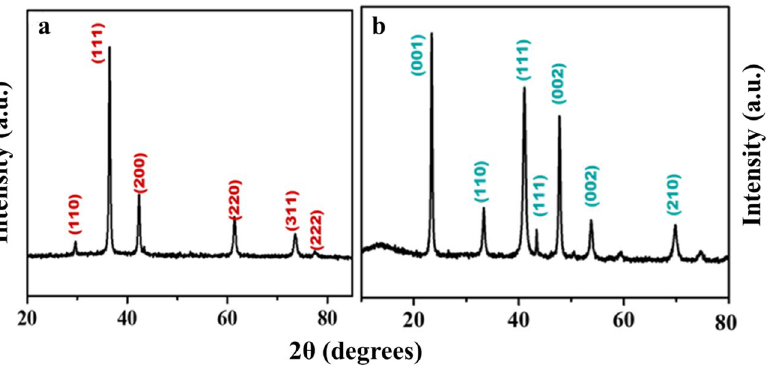
Figure 2. X-ray diffraction pattern of ( a ) Cu 2 O nanoparticle and the as synthesized, ( b ) Cu 3 N at 300 °C/160 ml/ min ammonia flow rate.